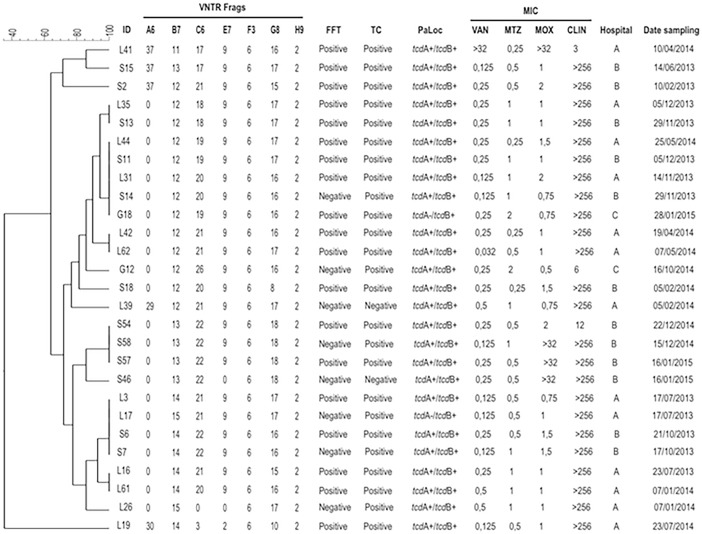
Analysis of ribotype 591 by MLVA.MLVA was applied to 27 isolates belonging to the ribotype 591. Dendrogram showing similarities of banding patterns generated with high-resolution capillary gel-based electrophoresis (CE)-PCR. MLVA clusters are identified by minimum-spanning tree: one clonal complex is defined by a MLVA type with less than a two-locus difference. In addition, free fecal toxin A/B (FFT), toxin in cell culture (TC), presence of PaLoc genes (tcdA/tcdB), minimal inhibitory concentrations (MIC) for vancomycin (VAN), metronidazole (MTZ), moxifloxacin (MOX) and clindamycin (CLIN) are shown for each isolate with the respective breakpoints. VNTR, variable-number tandem repeat.